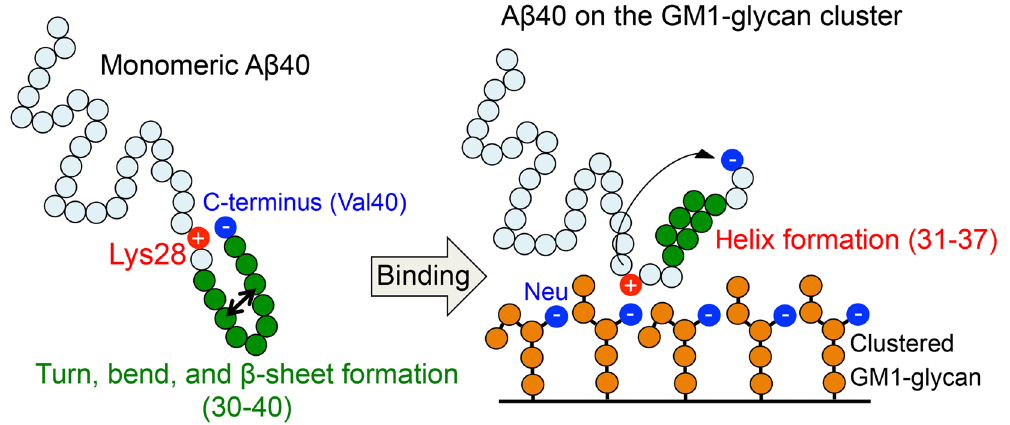
Figure 9. A schematic figure of the helix formation mechanism of A β 40 at residues 31–37 on the GM1-glycan